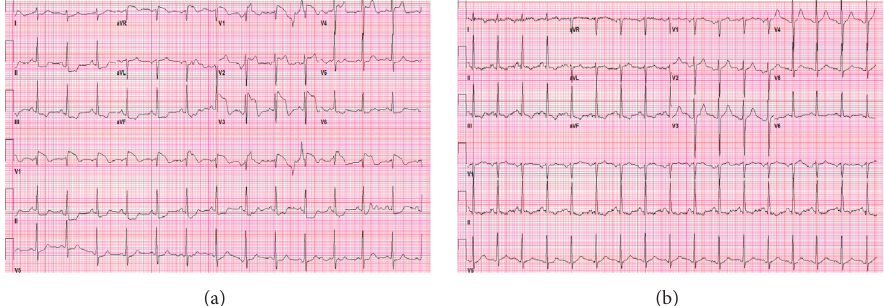
Figure 1: (a) Electrocardiogram showing ST-segment elevation in anterior leads with reciprocal changes in inferior leads (b) electrocardio- gram after needle decompression and chest tube placement showing complete resolution of ST-segment elevation in anterior leads.